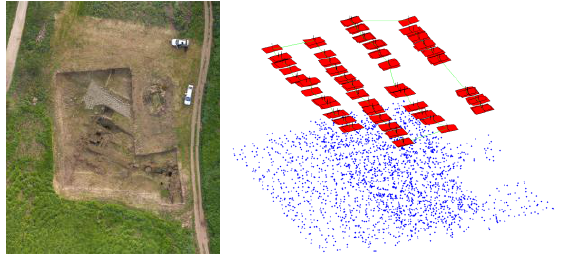
Figure 2: Automated image triangulation results for the UAV block over the area of Veio, Italy (ca 35 x 20 m).